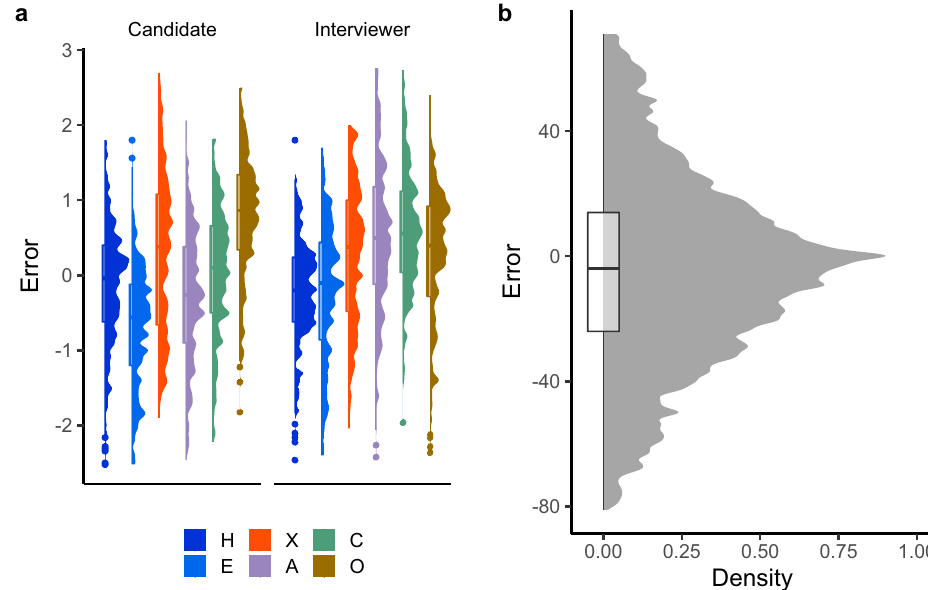
Figure 2. Density plots and boxplots of the distributions of errors in trait estimates and mental state inferences for the Interview Task. Error is calculated as the participant’s estimate minus the Target’s ground-truth report. Errors are taken from reports half-way through the interview and at the end. An error of zero indicates a perfect estimate, whilst non-zero datapoints indicate an error in the given rating in the given direction (i.e., positive = overestimate, negative = underestimate). (Panel a ) The distribution of errors for each trait for each Target ‘type’ (i.e., Interviewer or Candidate). H = honesty-humility, E = emotionality, X = extraversion, A = agreeableness, C = conscientiousness, O = openness to experience. (Panel b ) The distribution of mental state